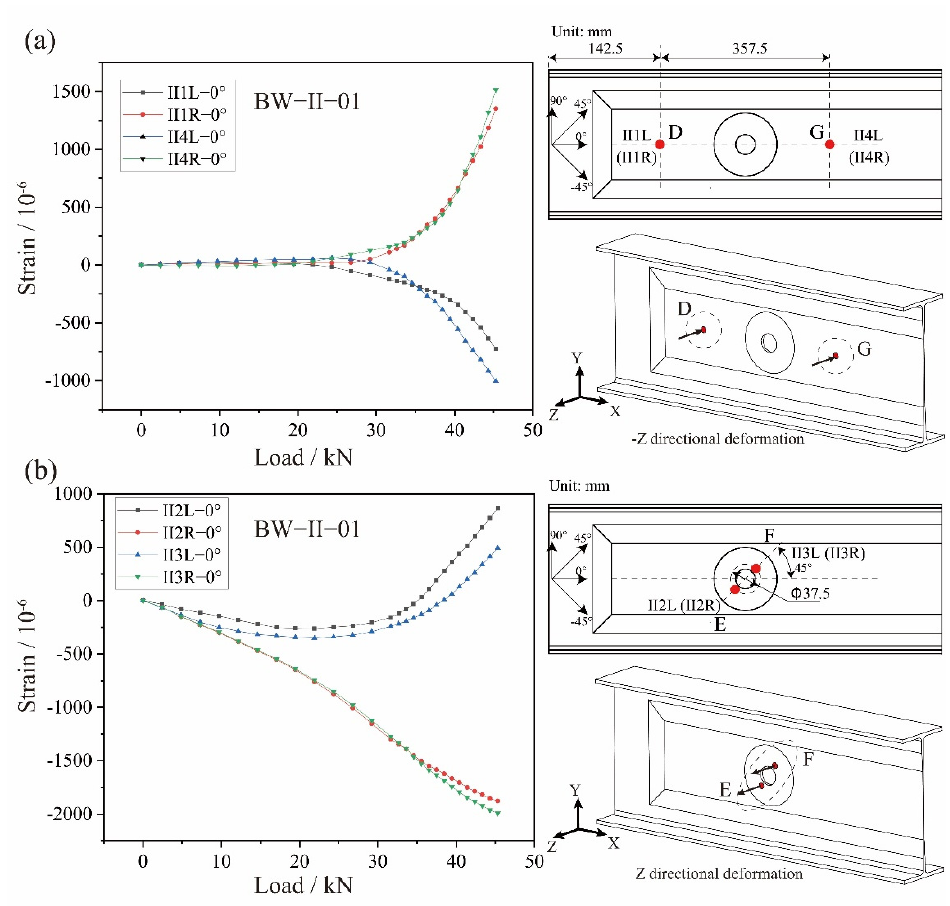
Figure 11. The characteristics of the off-plane deformation on the BW-II-01 composite beam web corresponding to the shear buckling: ( a ) the off-plane buckling deformation of Point D & G and the nearby regions; ( b ) the off-plane buckling deformation of Point E & F and the nearby region.